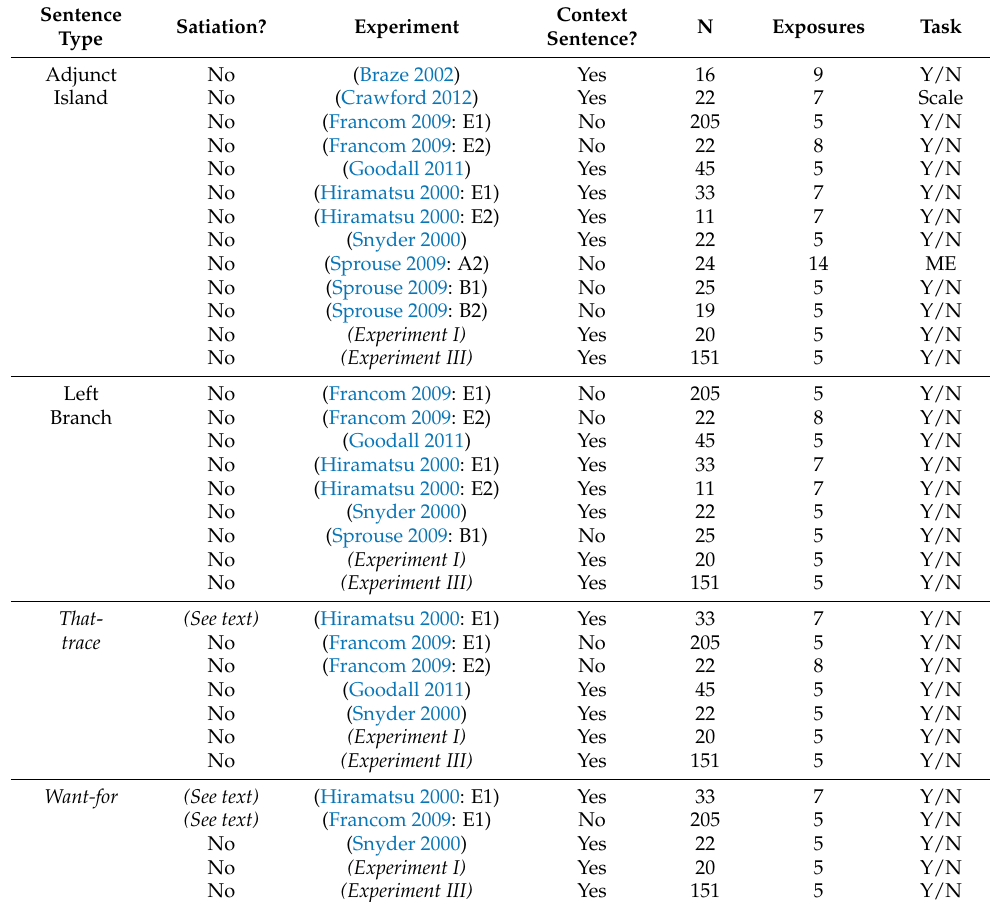
Table 5. Sentence types on which studies have consistently failed to induce satiation. (“ME” = magnitude estimation; “Y/N” = yes/no